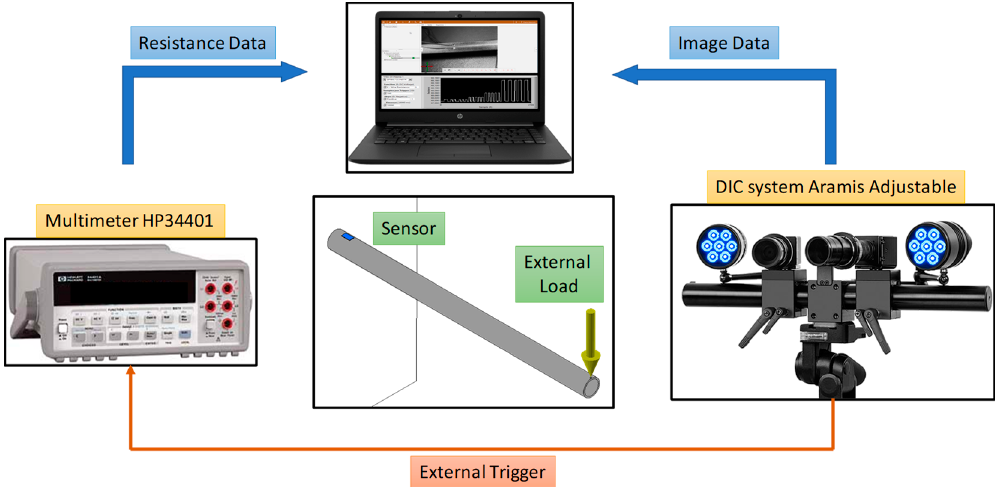
Figure 8. Experimental setup for the characterization of a strain gauge printed on a conduit. The DIC system records the deformation in the conduit area including the sensor, while the multimeter measures the electrical resistance of the sensor. A notebook collects and controls the two instruments. The acquisition of the resistance is triggered on the ACQUISITION of the images taken by DIC system. The conduit is anchor at the end where the sensor is printed, while external loads are applied on the free end to induce a